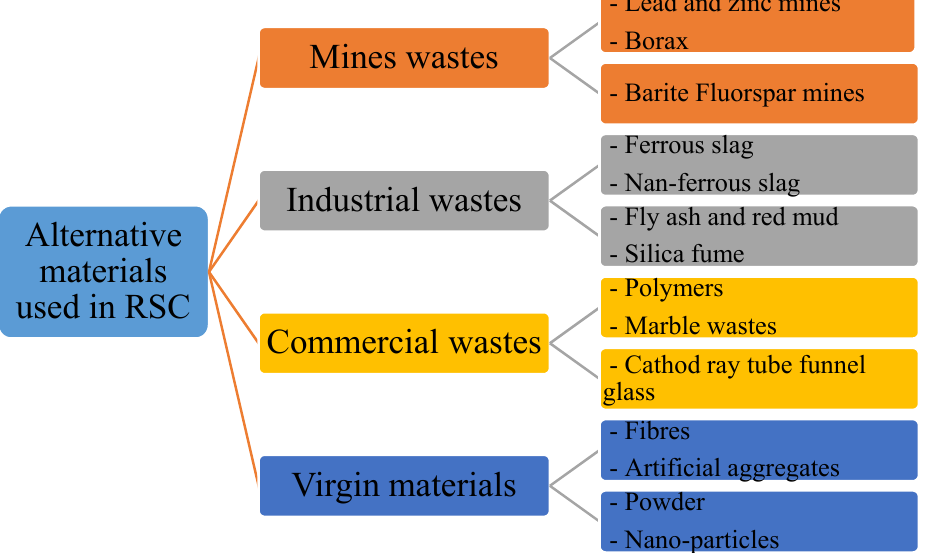
Figure 3. Alternative materials used in RSC (adapted with improvements from [21]).